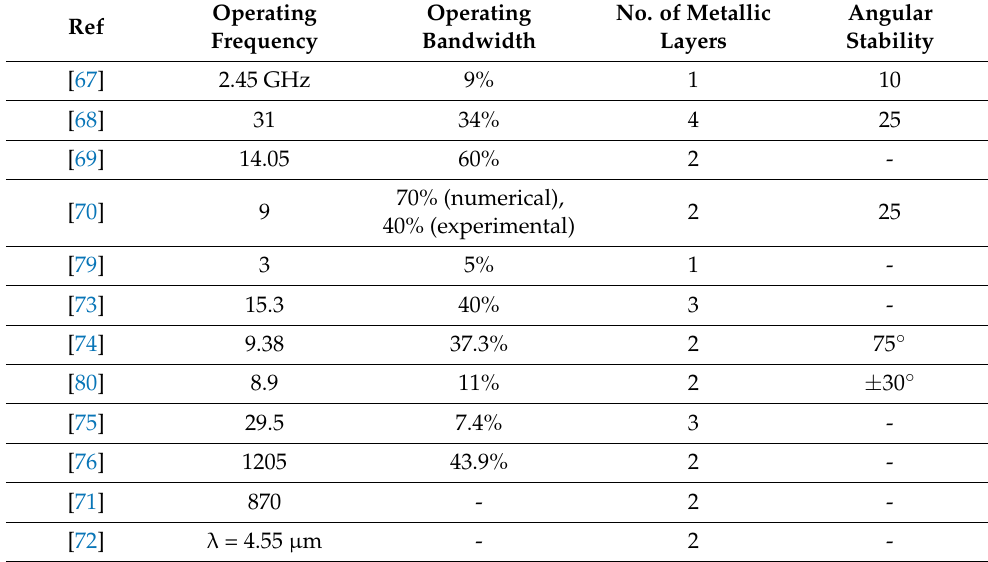
Table 1. State-of-the-art single-band MS-T-based LP-to-CP converters.